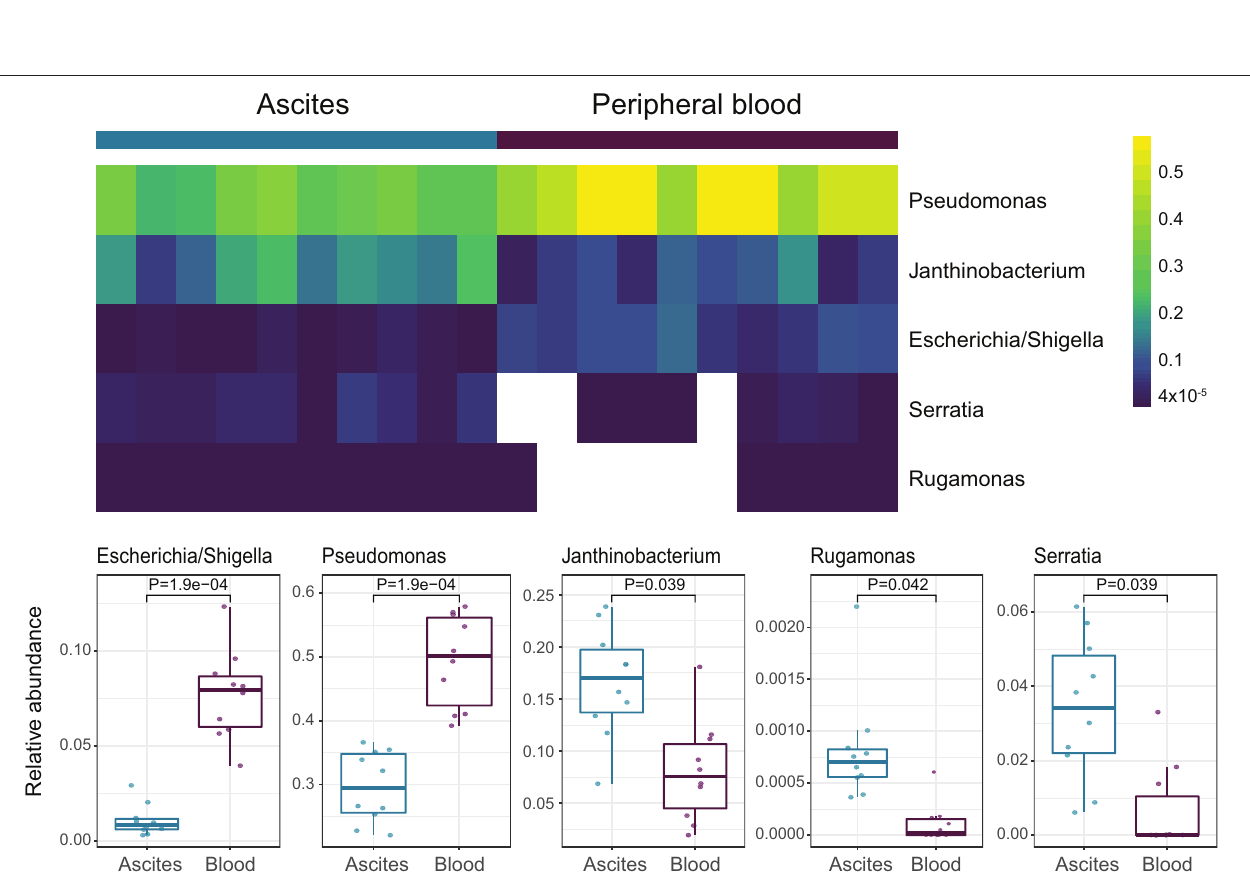
FIGURE 5 | Genera differentially abundant among ascites and blood